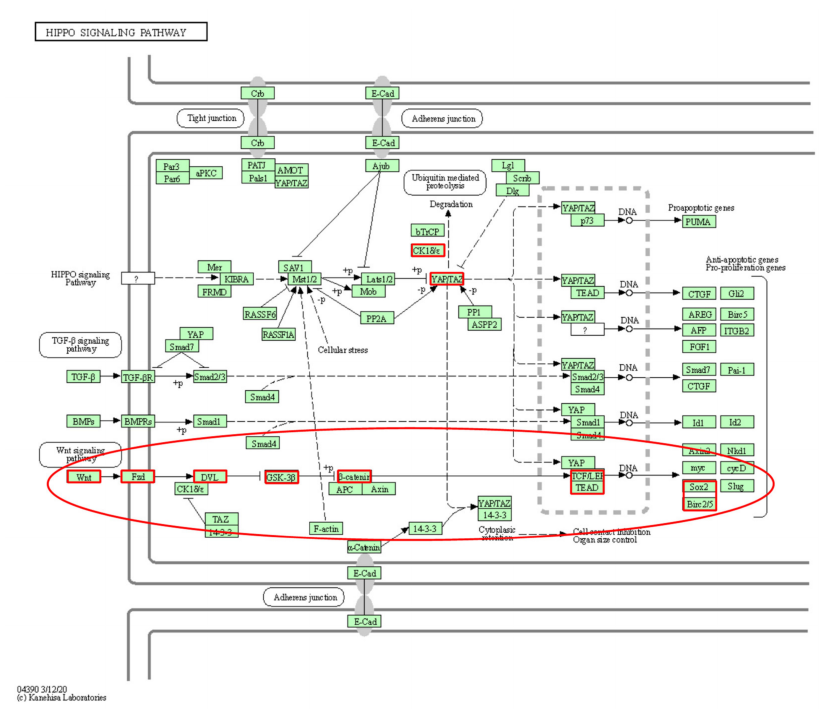
Figure 8. The Hippo signaling pathway in KEGG. Red borders represent genes mapped to the subpathway. Key subpathway region is shown in red ellipse.